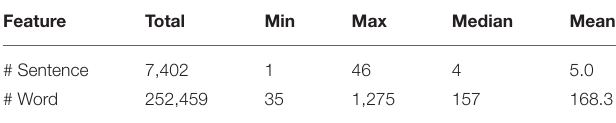
TABLE 1 | Statistics of the selected snippets.